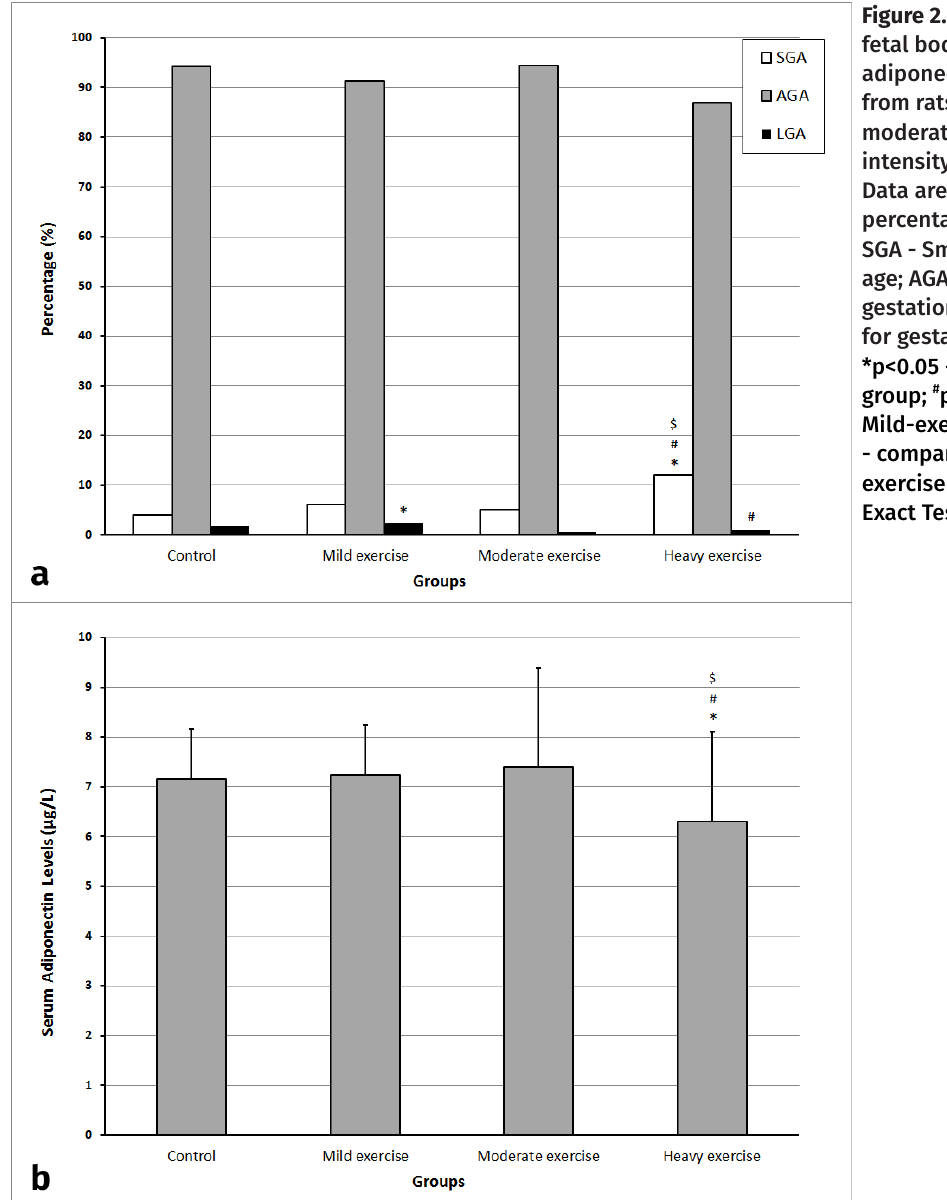
Figure 2. a - Classification of fetal body weight, b - Serum adiponectin levels of fetuses from rats submitted to mild, moderate and heavy-exercise intensity during pregnancy. Data are presented as